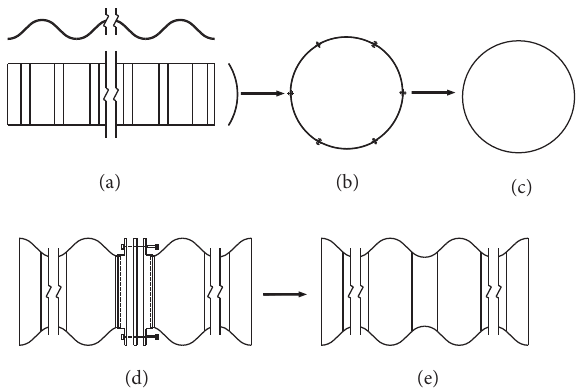
Figure 8: Simplification of assembly and flange connections: (a) corrugated steel plate, (b) assembly type corrugated steel pipe, (c) simplification of assembly, (d) flange connection of annular corrugated steel pipe, and (e) simplification of flange connection.